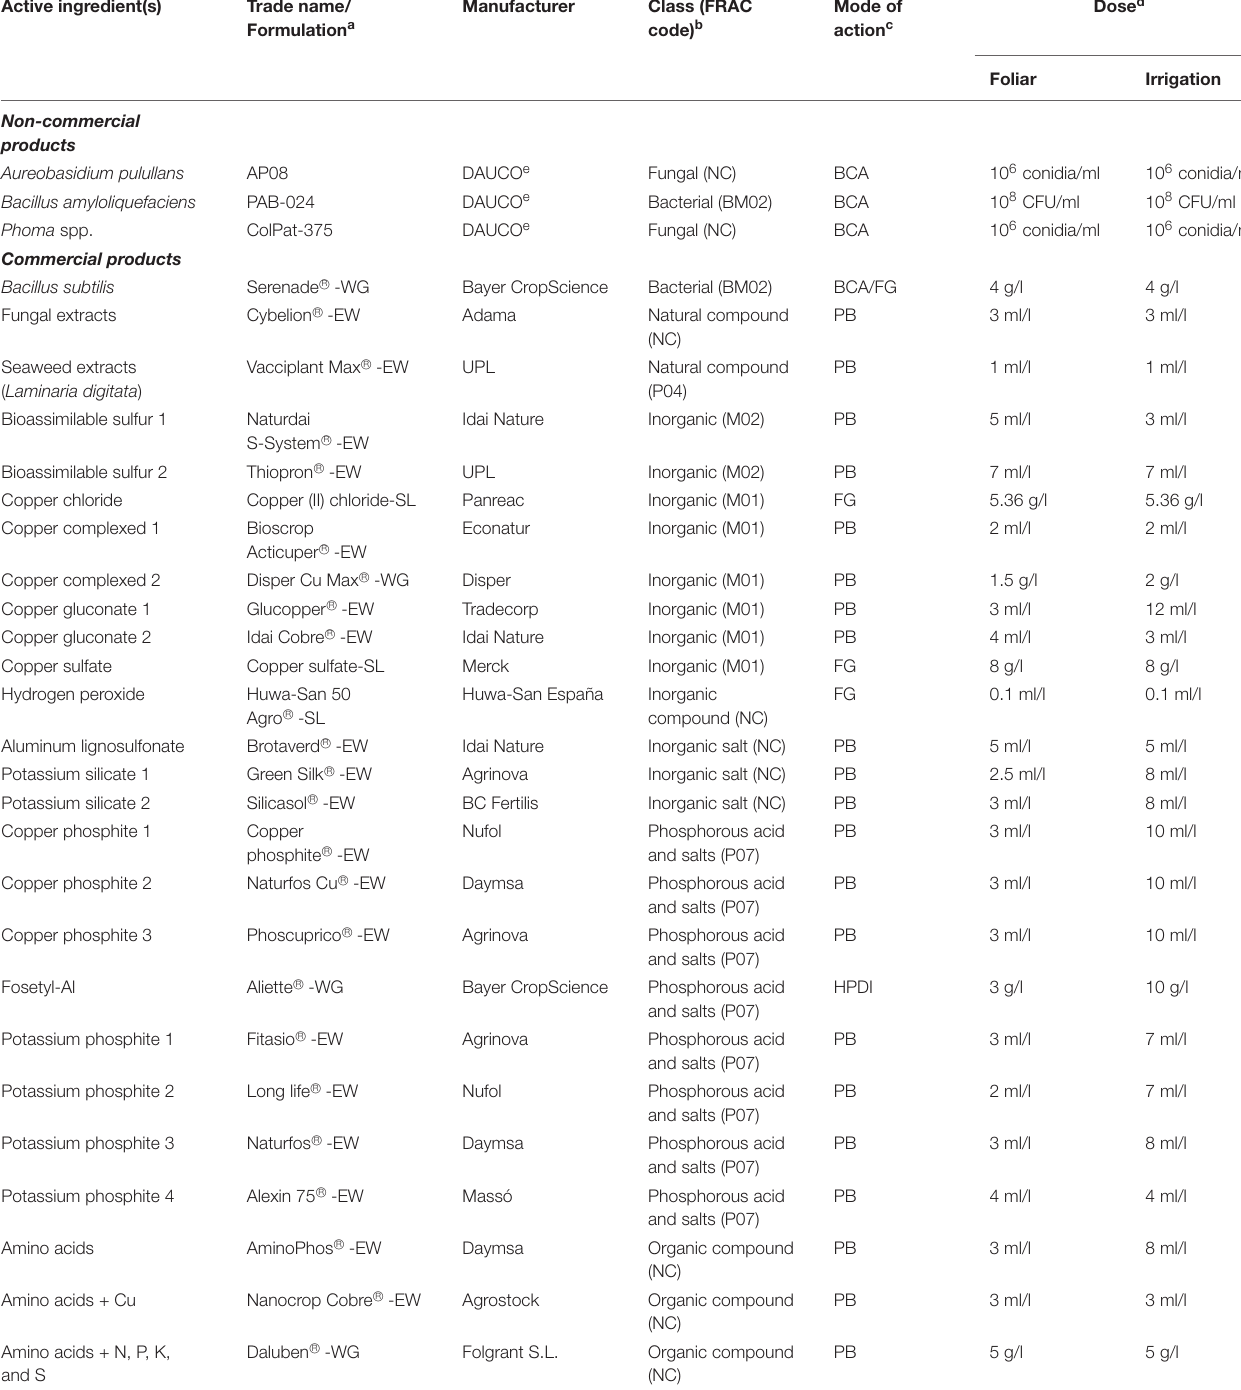
TABLE 1 | Biostimulants, resistance inductors and biological products evaluated against VWO. Active